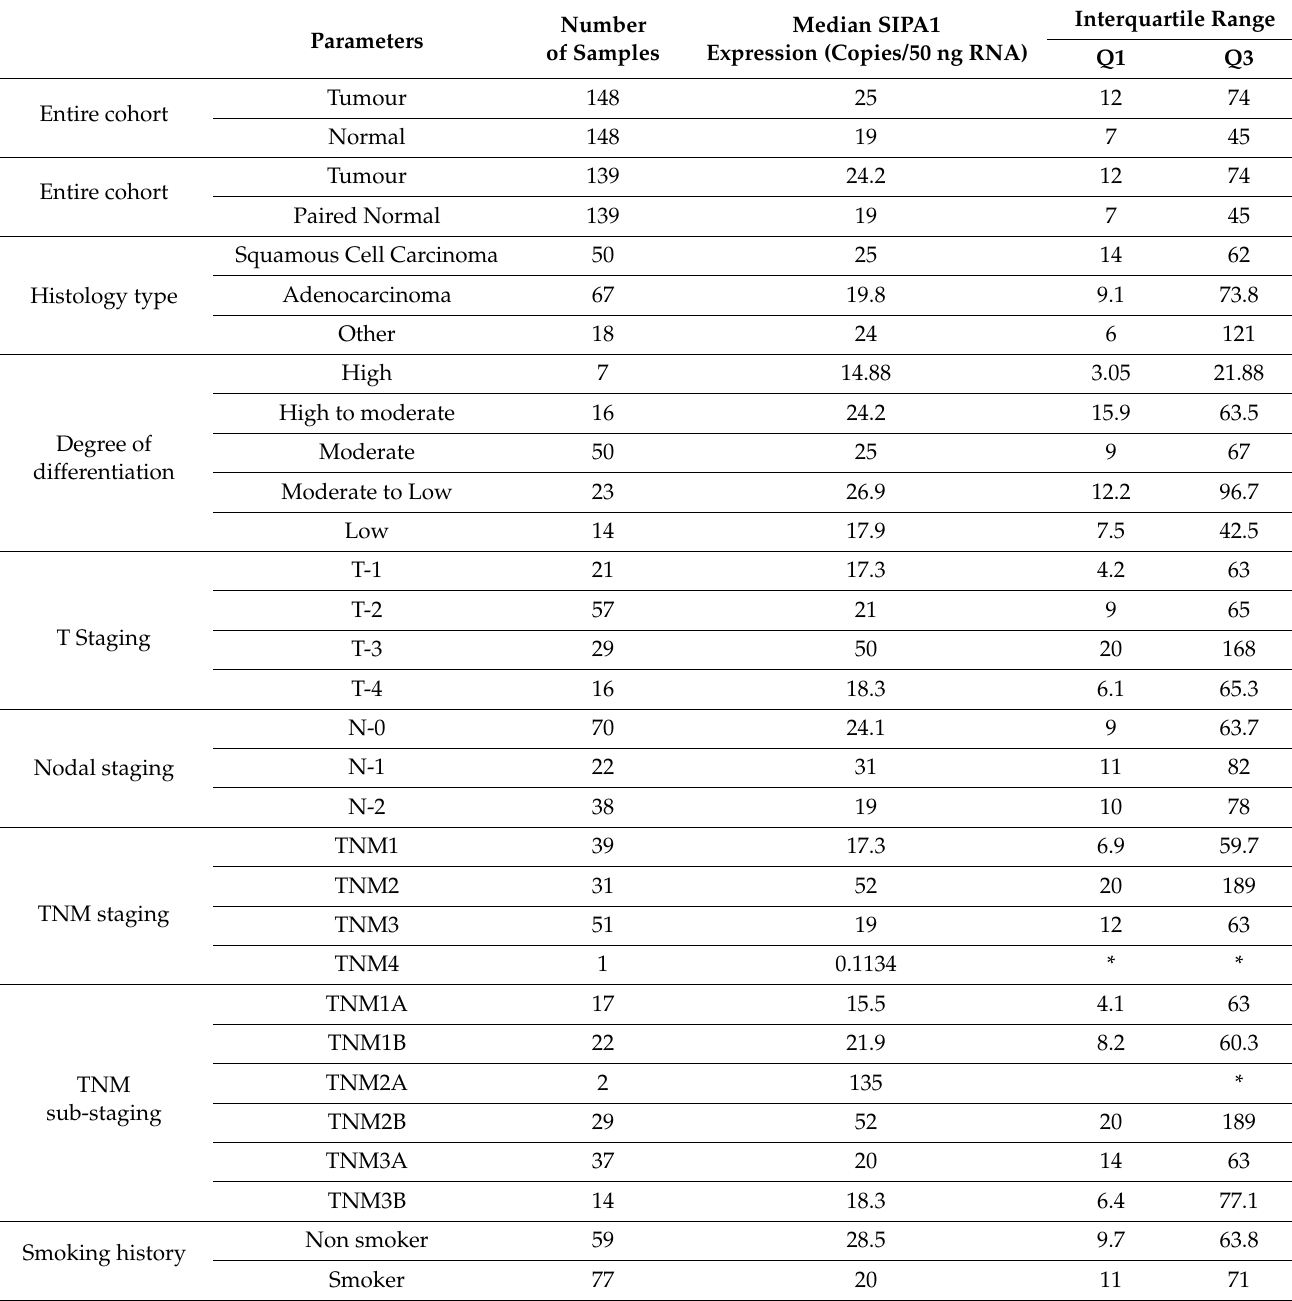
Table 1. Expression level of SIPA1 transcripts in relation to clinical and pathological demographics of the Peking lung cancer (and normal tissue) cohort. Interquartile Number Median SIPA1 Parameters of Samples Expression (Copies/50 ng RNA)